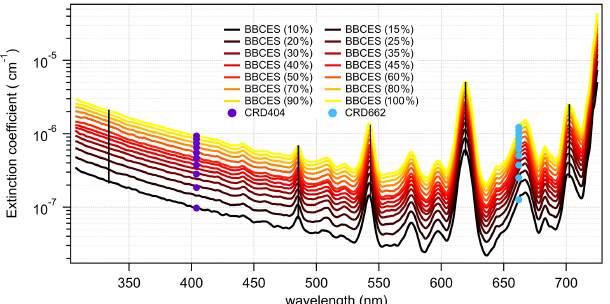
Figure 6. Wavelength-dependent extinction coefficients of CH 4 + He mixtures as a function of CH 4 mixing ratio. The colored lines represent extinction coefficients obtained from BBCES sys- tem and markers represent results from CRDS setup. Measurements were performed with CH 4 percentage within 10% and 100% with a 10% step. Moreover, BBCES measurements were also performed for 15%, 25%, 35%, and 45% CH 4 . The number concentration of 100% methane was 2.50143 × 10 19 molec.cm − 3 . Data at selected wavelengths (vertical lines) are shown in Fig.